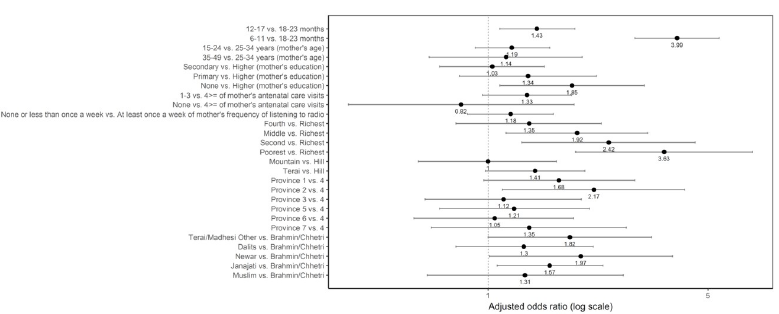
Fig 16. Odds ratio plot with 95% confidence intervals for not meeting the minimum dietary diversity among Nepalese children aged 6 to 23 months.